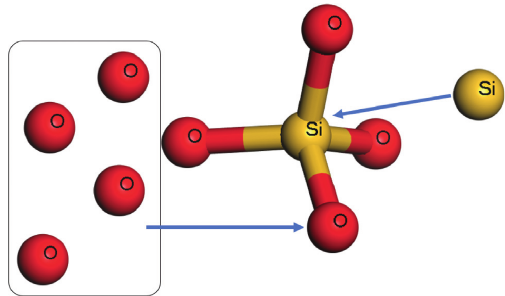
Figure 11: Schematic diagram for the changes of the [SiO